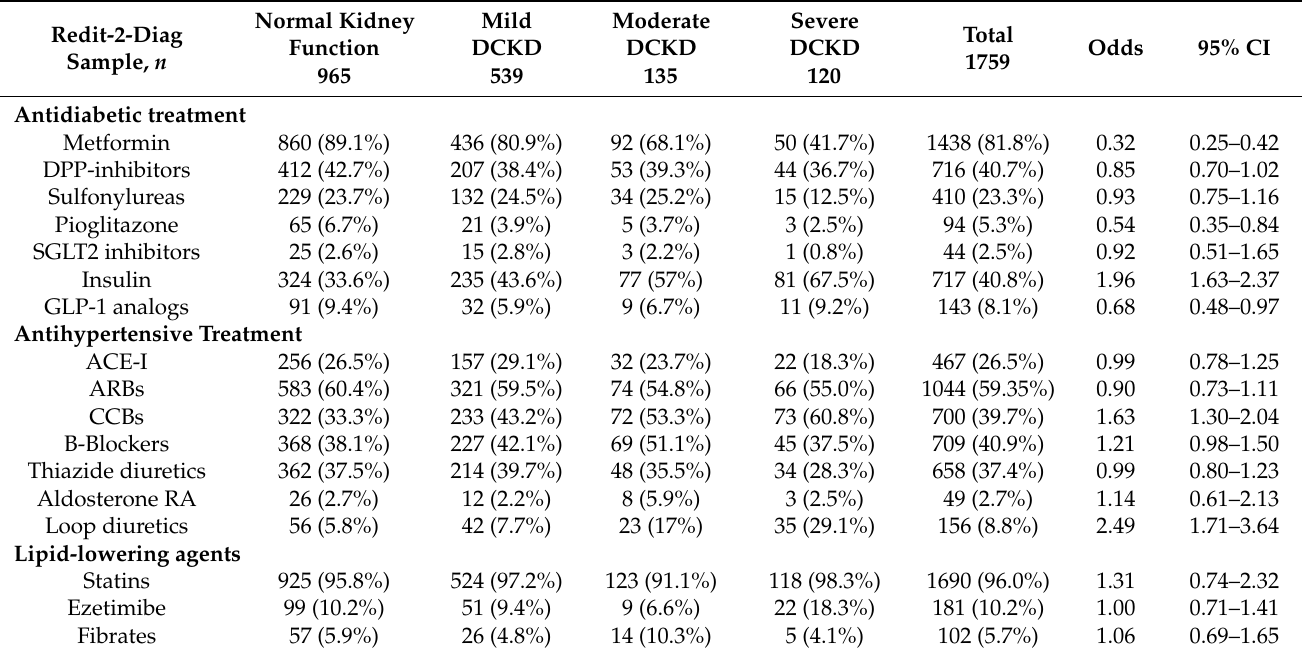
Table 2. Pharmacological treatment. Two-group analysis (normal kidney function vs. DCKD). Abbreviations: ACE-I, angiotensin-converting enzyme inhibitor; ARBs, angiotensin II receptor blockers; CCBs, calcium channel blockers; Aldos- terone RA, aldosterone receptor